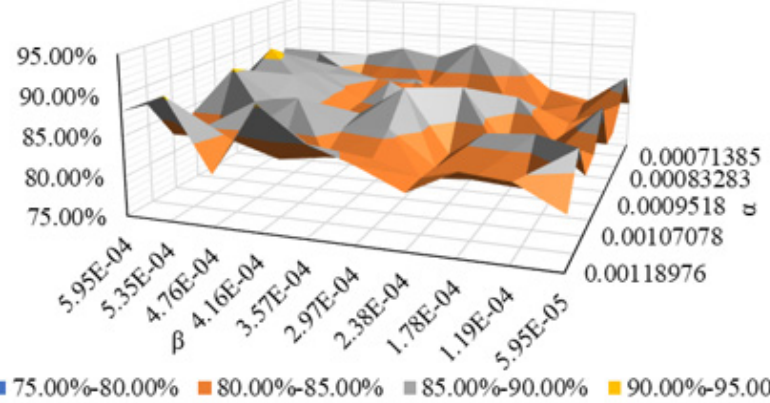
Figure 6. Precision change graph.